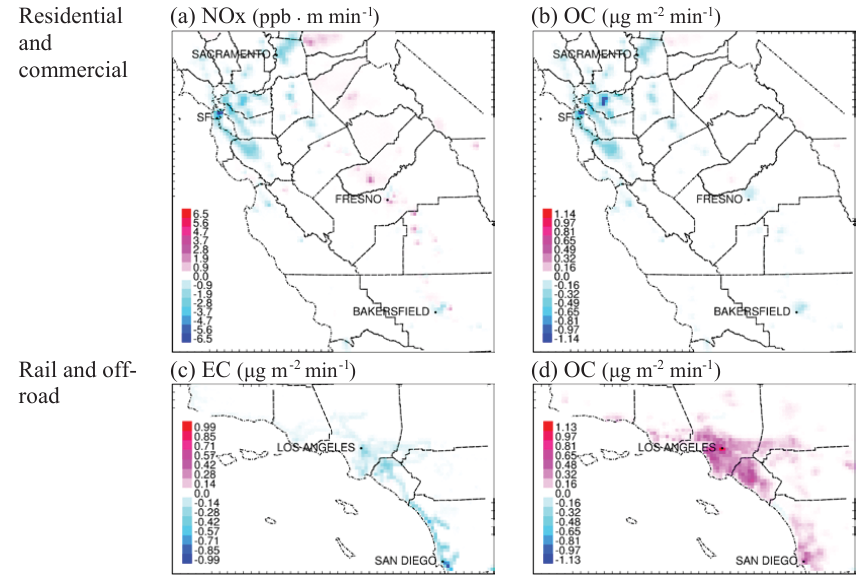
Figure 19. Change in emissions in the GHG-Step scenario relative to the BAU scenario. (a) NO x from residential and commercial sources (ppbmmin − 1 ), (b) particulate OC from residential and commercial sources (µgm − 2 min − 1 ), (c) particulate EC from off-road and rail sources (µgm − 2 min − 1 ), and (d) particulate OC from off-road and rail sources (µgm − 2 min − 1 ).